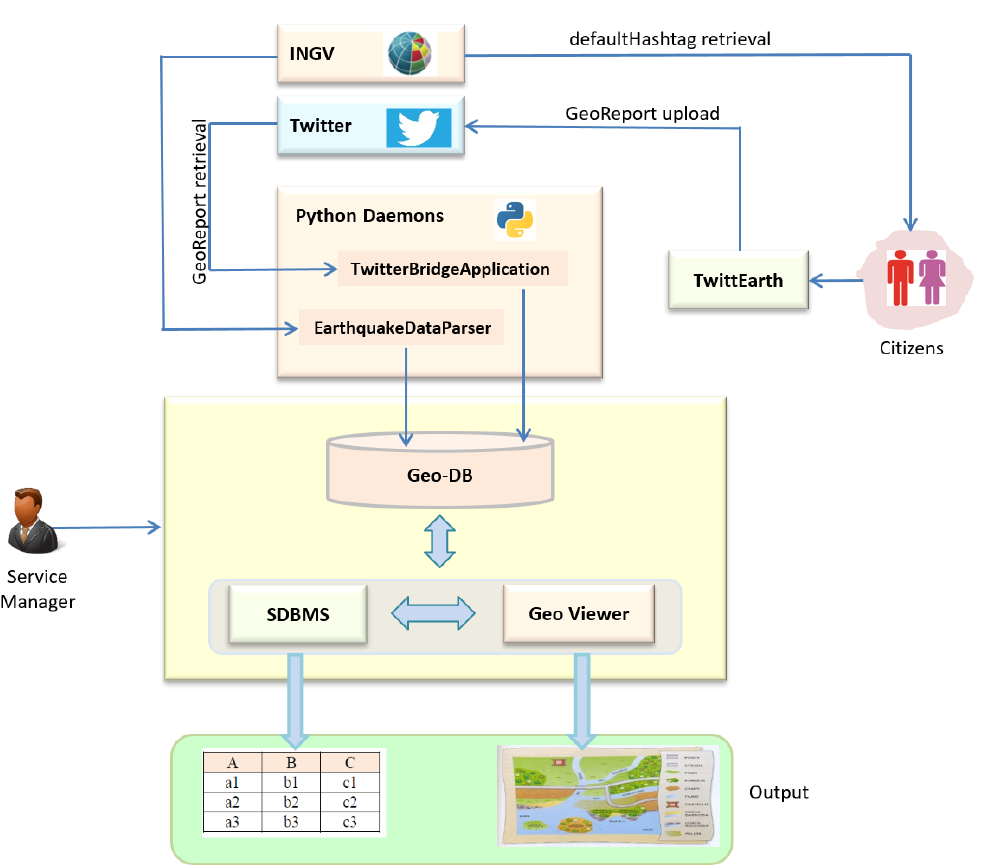
Figure 2. Architecture of the implemented Service . SDBMS stands for Spatial Database Management